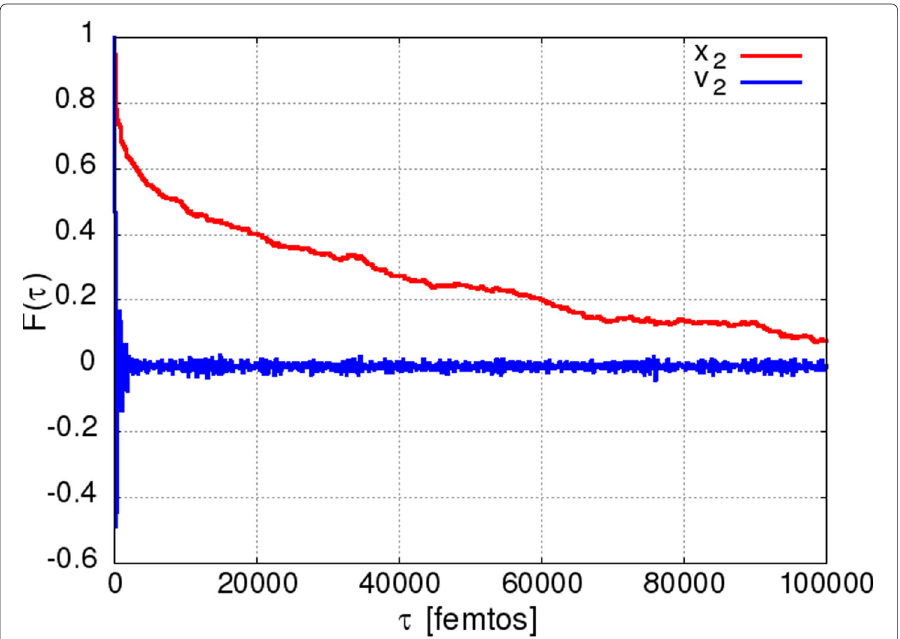
Fig. 1 Normalized auto-correlation function of the second component of the velocity (blue curves) and position (red curves) of an atom obtained in MD at T = 0.125 (cid:7) LJ / k